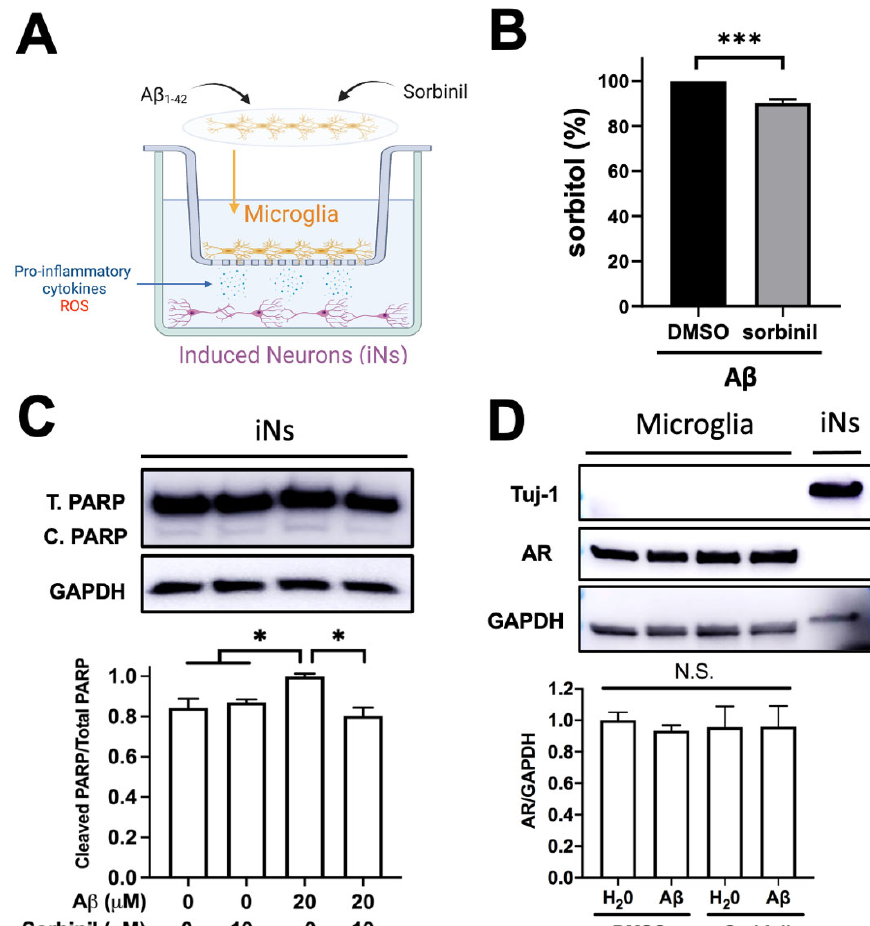
Figure 5. AR inhibition alleviates neuron death in microglia–induced neuron (iN) co ‐ culture. ( A ) Diagram of co ‐ culture setup for microglia and iNs. ( B ) Sorbitol assay indicated that sorbinil would attenuate sorbitol accumulation in the BV 2 cells. ( C ) Western blots and corresponding ratio of cleaved ‐ PARP (C. PARP) over total ‐ PARP (T. PARP) expression in iNs following treatment with β‐ amyloid (A β ) and/or sorbinil. ( D ) Western blots and corresponding quantification of AR and Tuj1 protein expression in microglia and iNs following treatment with A β and/or sorbinil. GAPDH is a loading control. Data shown are means ± SEM (N ≥ 3). * p < 0.05, *** p < 0.005, N.S. = not significant.